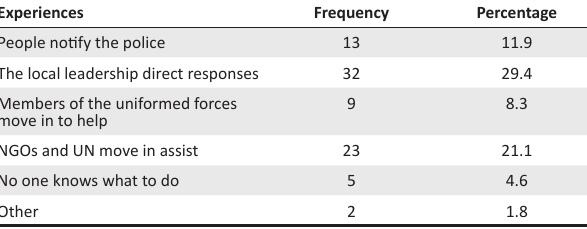
TABLE 3: Disaster response experiences.